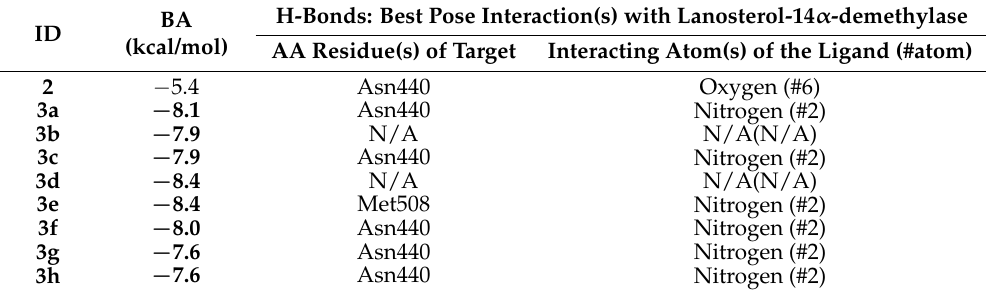
Table 7. Binding affinity of the tested compounds (best poses) towards lanosterol-14 α -demethylase. H-Bonds: Best Pose Interaction(s) with Lanosterol-14 α BA ID (kcal/mol)